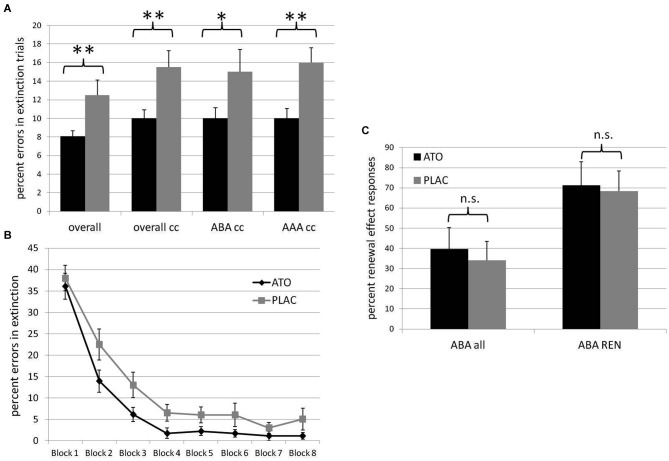
Behavioral results. (A) Percentage of errors in extinction trials in the ATO (black) and PLAC (gray) groups. The ATO group made significantly less errors than the PLAC group over all extinction trials (overall), in extinction trials with consequence change only (overall cc), in ABA extinction trials with consequence change (ABA cc) and in AAA extinction trials with consequence change (AAA cc). (B) Extinction learning curves for ATO (black) and PLAC (gray) participants, with the extinction session divided into eight blocks of 10 trials each. During initial extinction in block 1, error rates did not differ between groups. However, in subsequent learning, the PLAC group was significantly slower in reducing errors during blocks 2–5. (C) Percent renewal effect responses in all participants (ABA all) and only in those participants who actually showed a renewal effect (ABA REN) in the ATO (black) and PLAC (gray) groups. ATO and PLAC groups did not differ with regard to the strength of the renewal effect they exhibited.